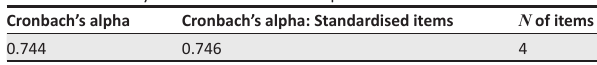
TABLE 2: Reliability statistics: Cronbach’s alpha for four-item